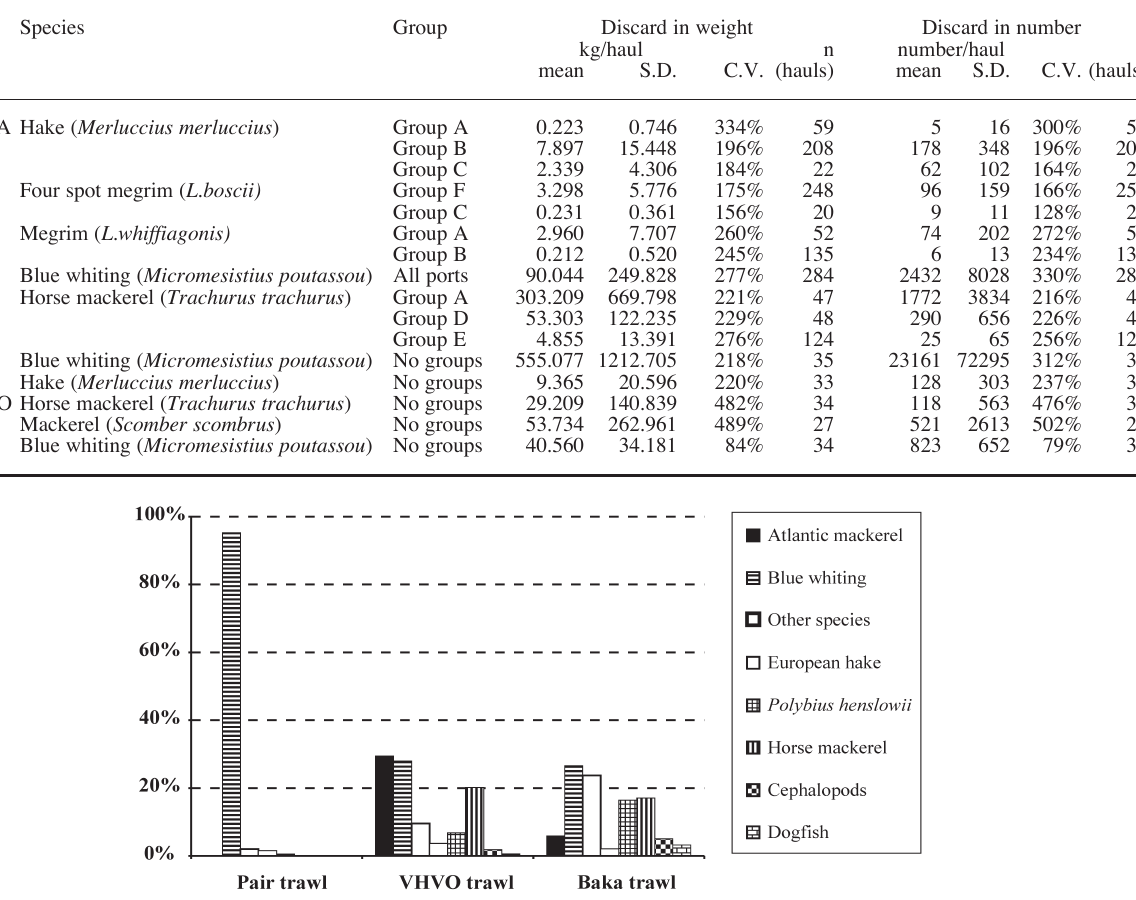
F IG . 4. – Discard composition in percentage of weight for the different